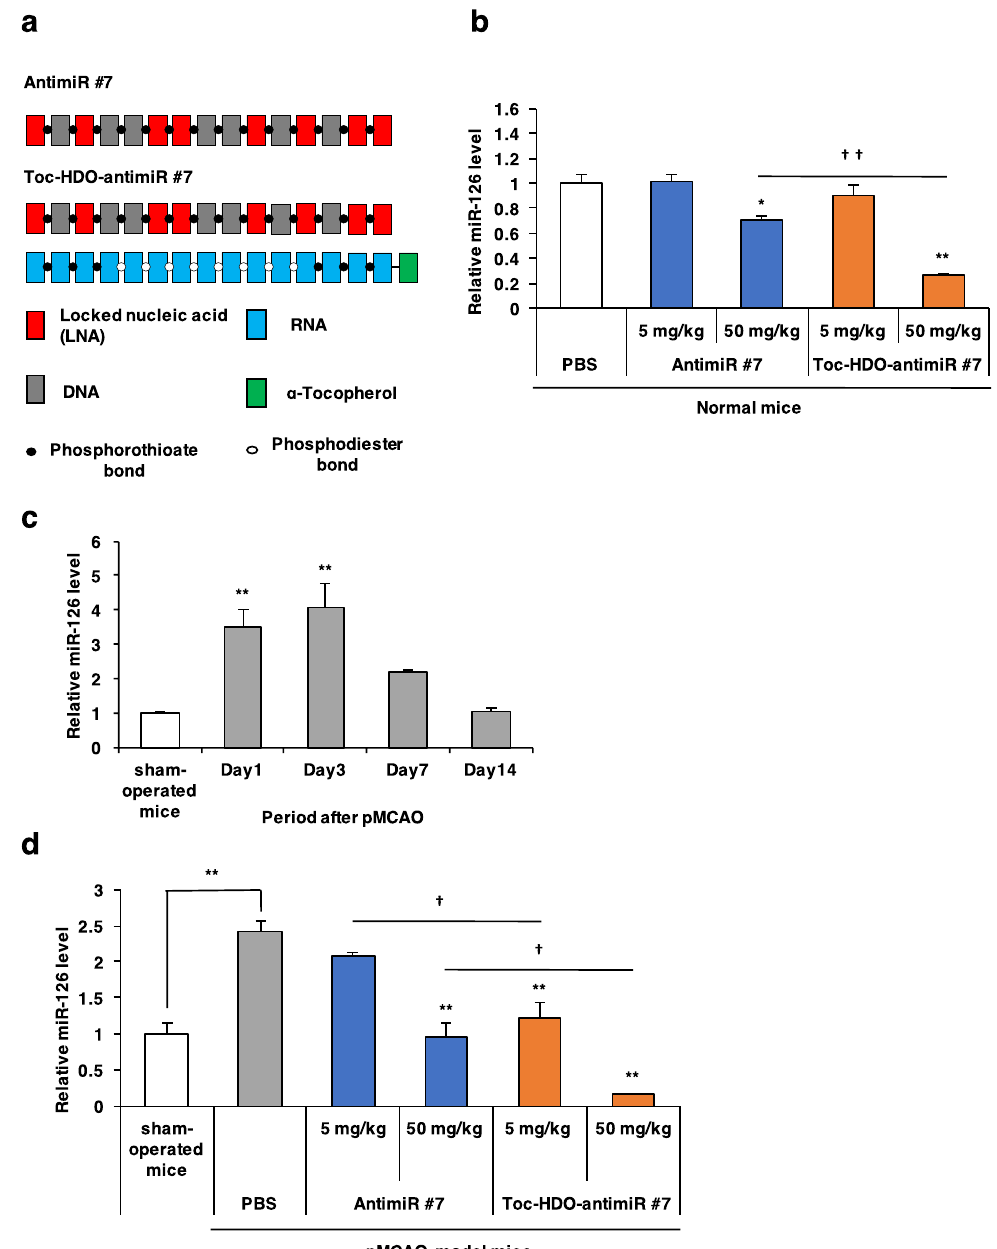
Figure 2. Inhibition of microRNA in BECs after intravenous administration of Toc-HDO-antimiR #7. ( a ) Design of Toc-HDO-antimiR #7 and antimiR #7. ( b ) Quantitative reverse transcription PCR (qRT-PCR) analysis of miR-126 expression in the cerebral cortex from normal mice after intravenous administration of phosphate buffered saline (PBS), antimiR #7, or Toc-HDO-antimiR #7 at 5 mg/kg or 50 mg/kg (* P < 0.05, ** P < 0.01 versus PBS control; †† P < 0.01 versus antimiR #7). ( c ) Time course of miR-126 expression in the ischemic region after permanent middle cerebral artery occlusion (pMCAO) (** P < 0.01 versus sham-operated mice). ( d ) qRT-PCR analysis of miR-126 expression in the cerebral cortex from sham-operated mice and the ischemic region from pMCAO model mice after intravenous administration of PBS, antimiR #7, or Toc-HDO- antimiR #7 at 5 mg/kg or 50 mg/kg (** P < 0.01 versus PBS control; † P < 0.01 versus antimiR #7). All data are relative to U6 small RNA levels and are presented as the mean ± s.e.m (n = 3 per group). P values were calculated using one-way ANOVA followed by ( c ) Dunnett’s test or ( b , d ) Tukey–Kramer